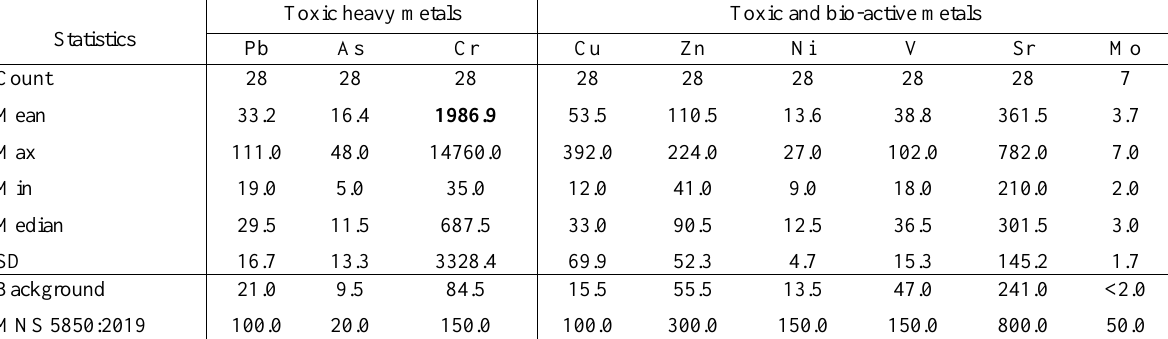
Table 3 . Descriptive statistics of heavy metals in soil, mg/kg